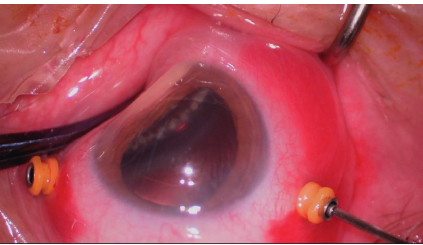
Figure 1: Laser fibers were inserted, and ciliary processes, with the septum, were lasered, one by one, under direct